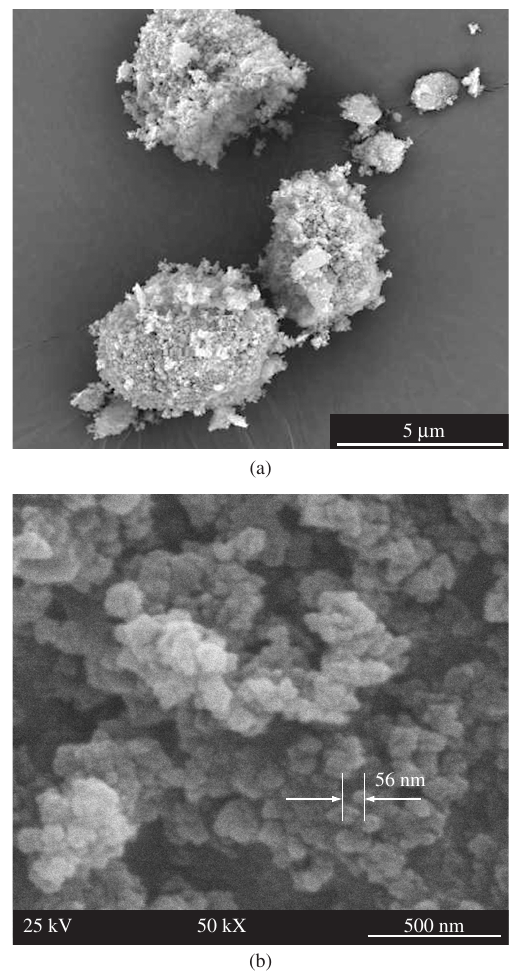
Figure 1. The curves of pH measures of colloidal solutions as a function of